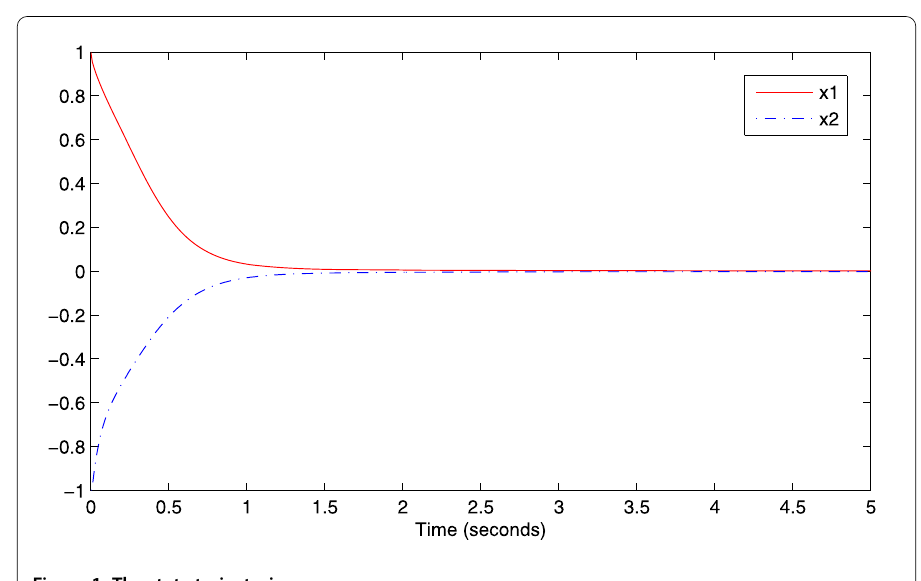
Figure 1 The state trajectories x 1 , x 2